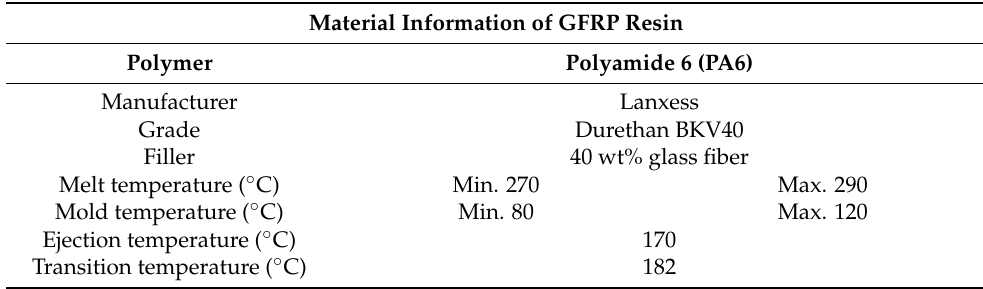
Figure 22. Two types of injection analysis models: ( a ) direct gate type and ( b ) side gate type. Table 8. Material information of GFRP resin used for injection analysis.